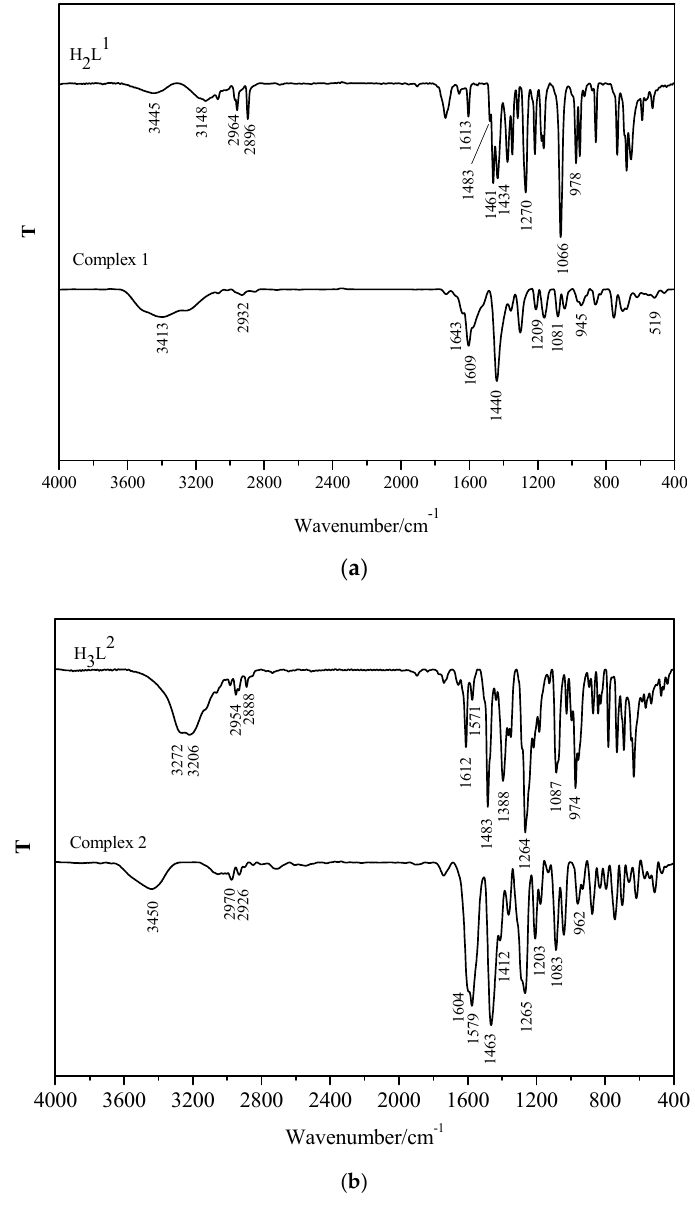
Figure 4. Infrared spectra of: ( a ) H 2 L 1 ; and ( b ) H 3 L 2 , and their corresponding complexes 1 and 2 .